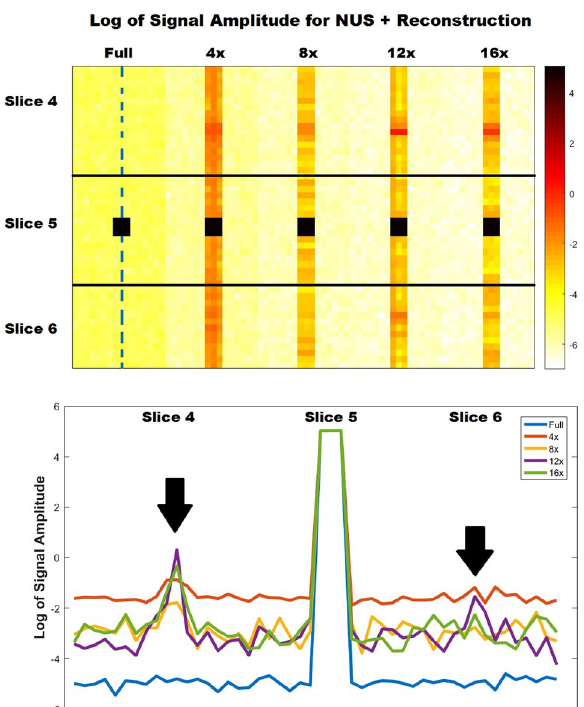
Figure 5. The virtual phantom results simulated with signal only in a 3 × 3 voxel region in the central slice (slice 5) are displayed. This vphantom demonstrates the signal leakage as a result of each non-uniform sampling scheme and reconstruction. The log of the NAA signal amplitudes are shown for the spatial display (top). Additionally, the profile shown by the blue dashed line is displayed for each NUS and reconstruction simulation (bottom). From the signal profiles, it is clear that there are signal leakages in the neighboring slices when utilizing 12x and 16x acceleration (black arrows). Surprisingly, 4x results have a uniform leakage of signal throughout the phase-encoded and slice direction due to less denoising. Signal leakage was generally lower than the true signal by 4 orders of magnitude for all of the acceleration